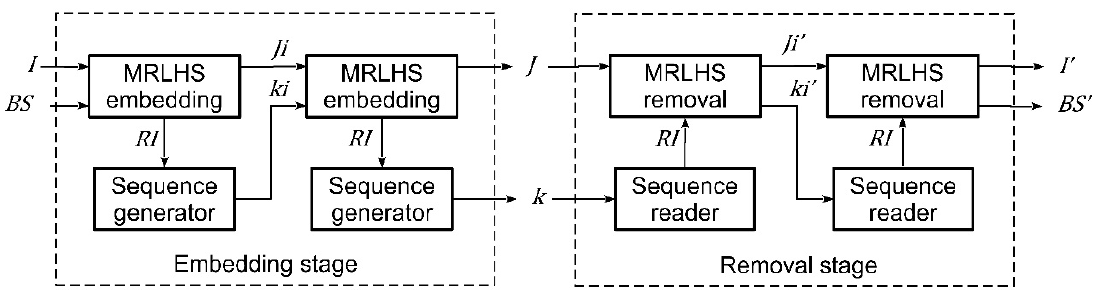
Figure 3. Embedding and removal stages based on MRLHS.